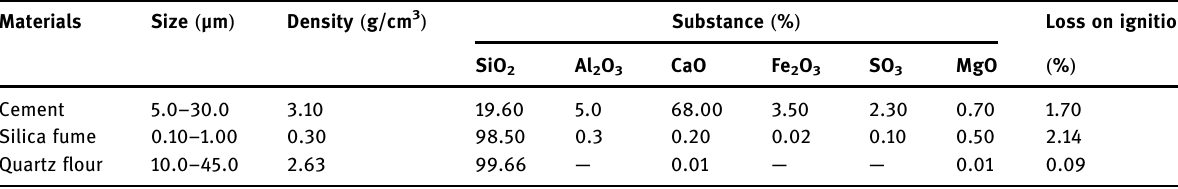
Table 1: Properties of the cement, silica fume, and quartz fl our Materials Size ( μ m )